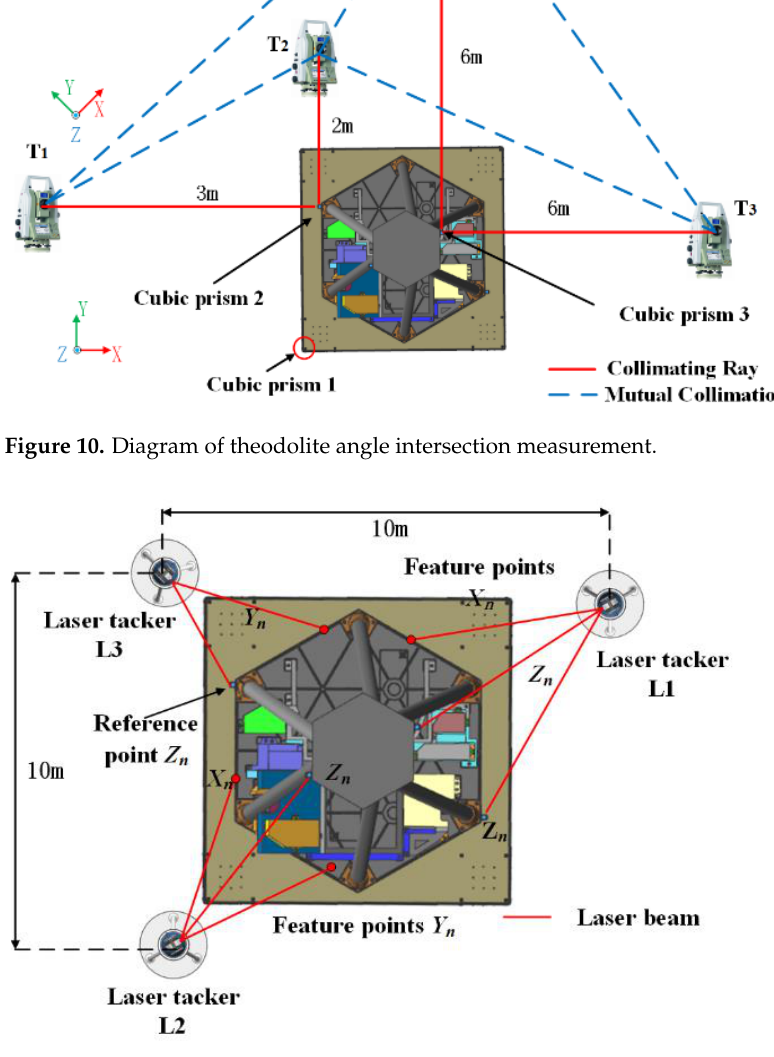
Figure 11. Diagram of laser tracker coordinate acquisition.